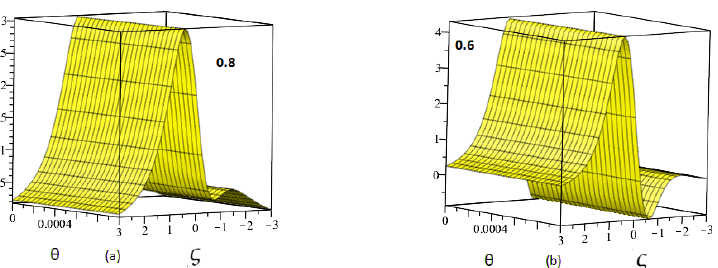
Figure 5. The obtained solution is graphically depicted at ( a ) ℘ = 0.8 and ( b ) ℘ = 0.6.